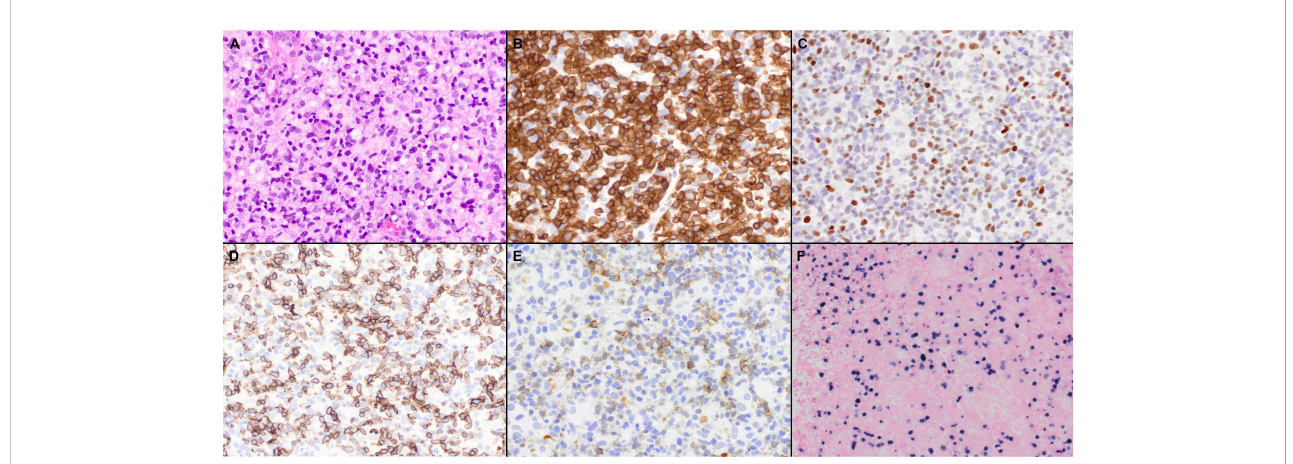
FIGURE 3 Histopathologic features of nodal TFH cell lymphoma, not otherwise speci fi ed (NOS). (A) In the case shown, the neoplasm is diffuse and composed predominantly of intermediate atypical lymphoid cells (40x); Features of AITL were not seen. (B) The tumor cells are positive for CD3 (40x); (C-E) BCL6 (C) , ICOS (D) , and PD-1 (E) are also variably positive in the neoplastic cells (40x); (F) Epstein-Barr virus-encoded small RNAs (EBER) shows positivity in scattered cells